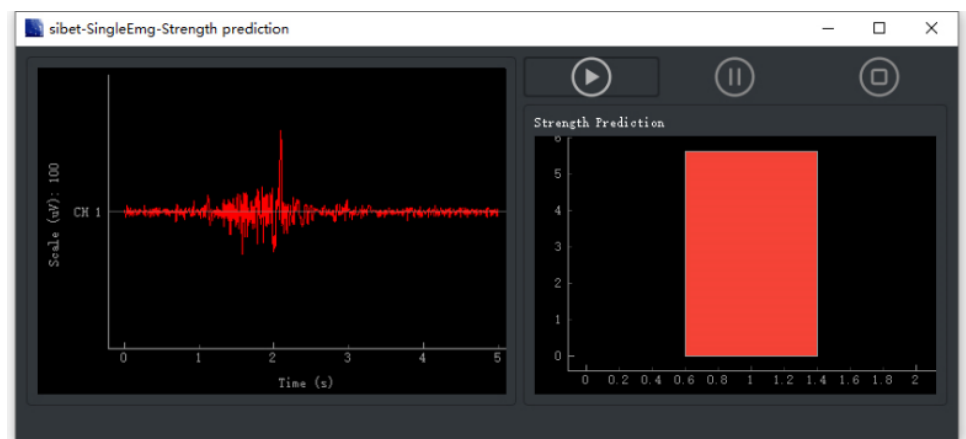
Figure 16. The strength prediction UI use single sEMG system.